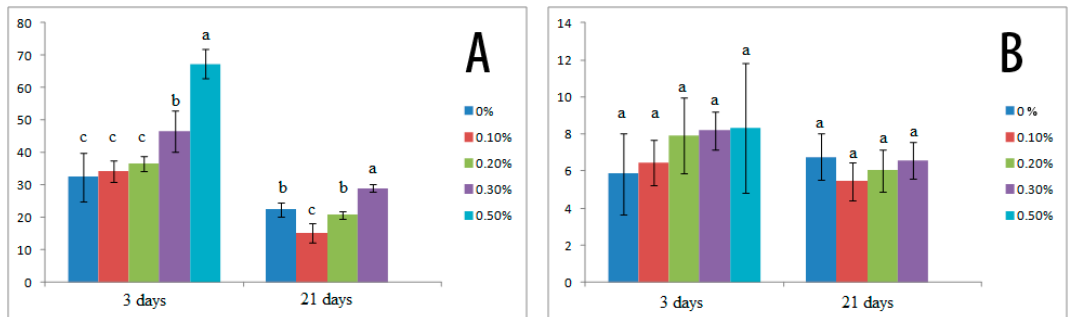
Figure 2. MDA content ( μ g g − 1 FW) in leaves ( A ) and roots ( B ) of mulberry plants grown for 3 and 21 days with increasing levels of soil salinity under greenhouse conditions. Data with the same letter are not significantly different ( P = 0.05).